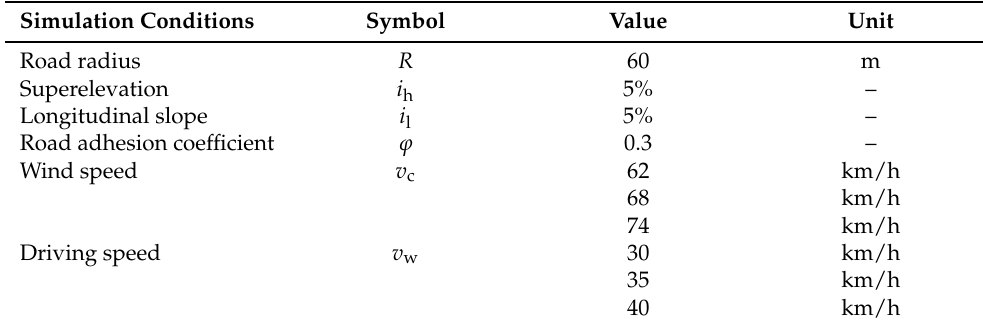
Table 3. Simulation experiment condition